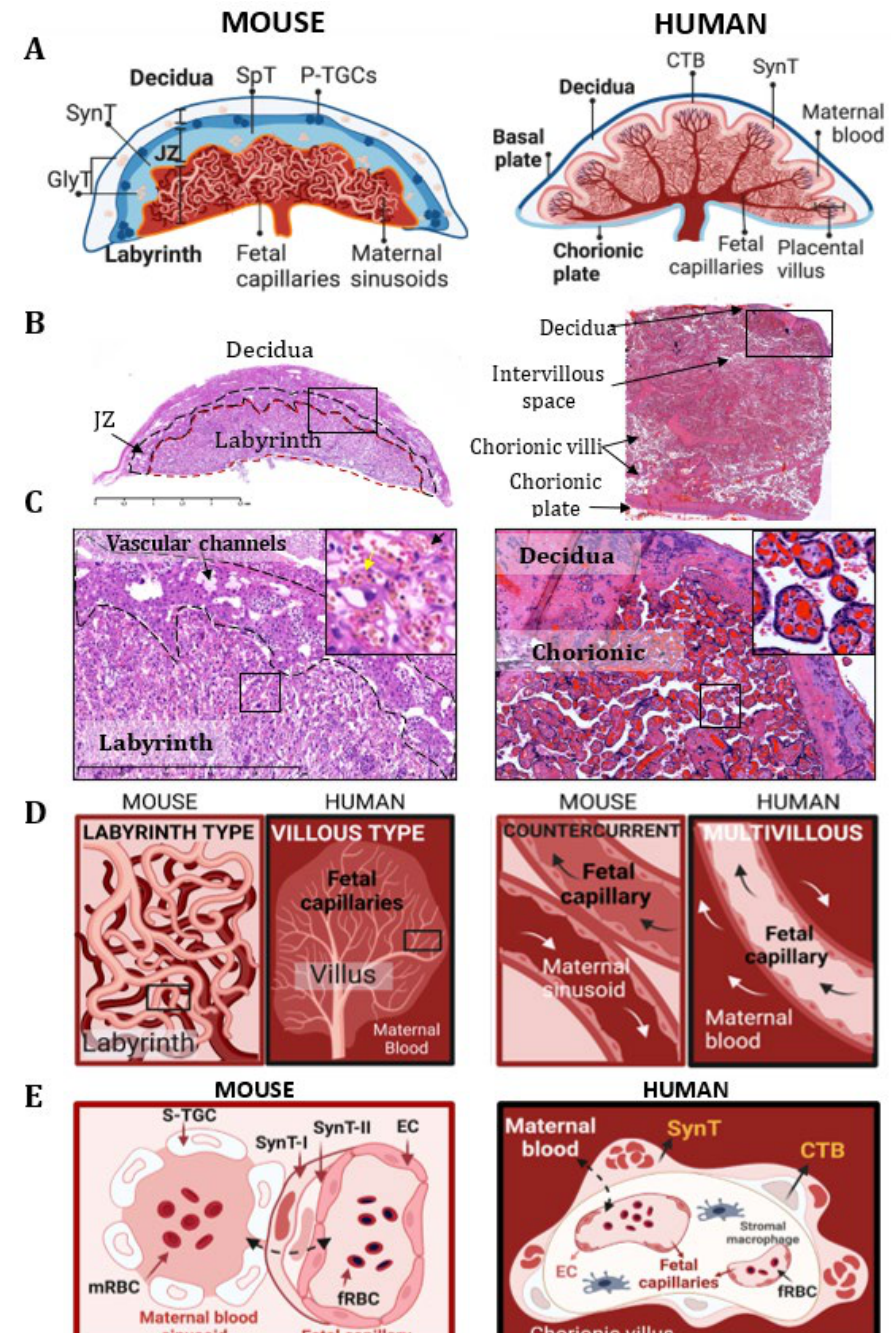
Figure 1. Structural and functional characteristics of mouse and human placentas ( A , B ). Schematic representation ( A ), with H&E-stained cross sections ( B ) of mature mouse (E14.5) and human placentas (40 weeks). Mouse placenta contains three main layers: the maternal decidua (Dec), the fetal-derived junctional zone (JZ), and the labyrinth (Lab). The JZ and labyrinth are respectively delineated by black and red dotted lines in the histological sections. The JZ is composed of GlyTs (glycogen trophoblast cells), SpTs (spongiotrophoblast cells), and P-TGCs (parietal trophoblast giant cells). The labyrinth consists of an anastomosing network of maternal blood sinusoids and fetal capillaries, which are surrounded by SynT cells (syncytiotrophoblasts). Scale bars: 2,5 mm (left) and 1 mm (right). The human placenta is composed of two different surfaces, the fetal surface (or chorionic plate) and the maternal surface (or basal plate), which are attached to the maternal decidua. Indeed, multiple chorionic villi, when arising from the chorionic plate, contain fetal capillaries and are sur- rounded by SynT and CTB (cytotrophoblast) cell layers. Moreover, maternal blood circulates in the